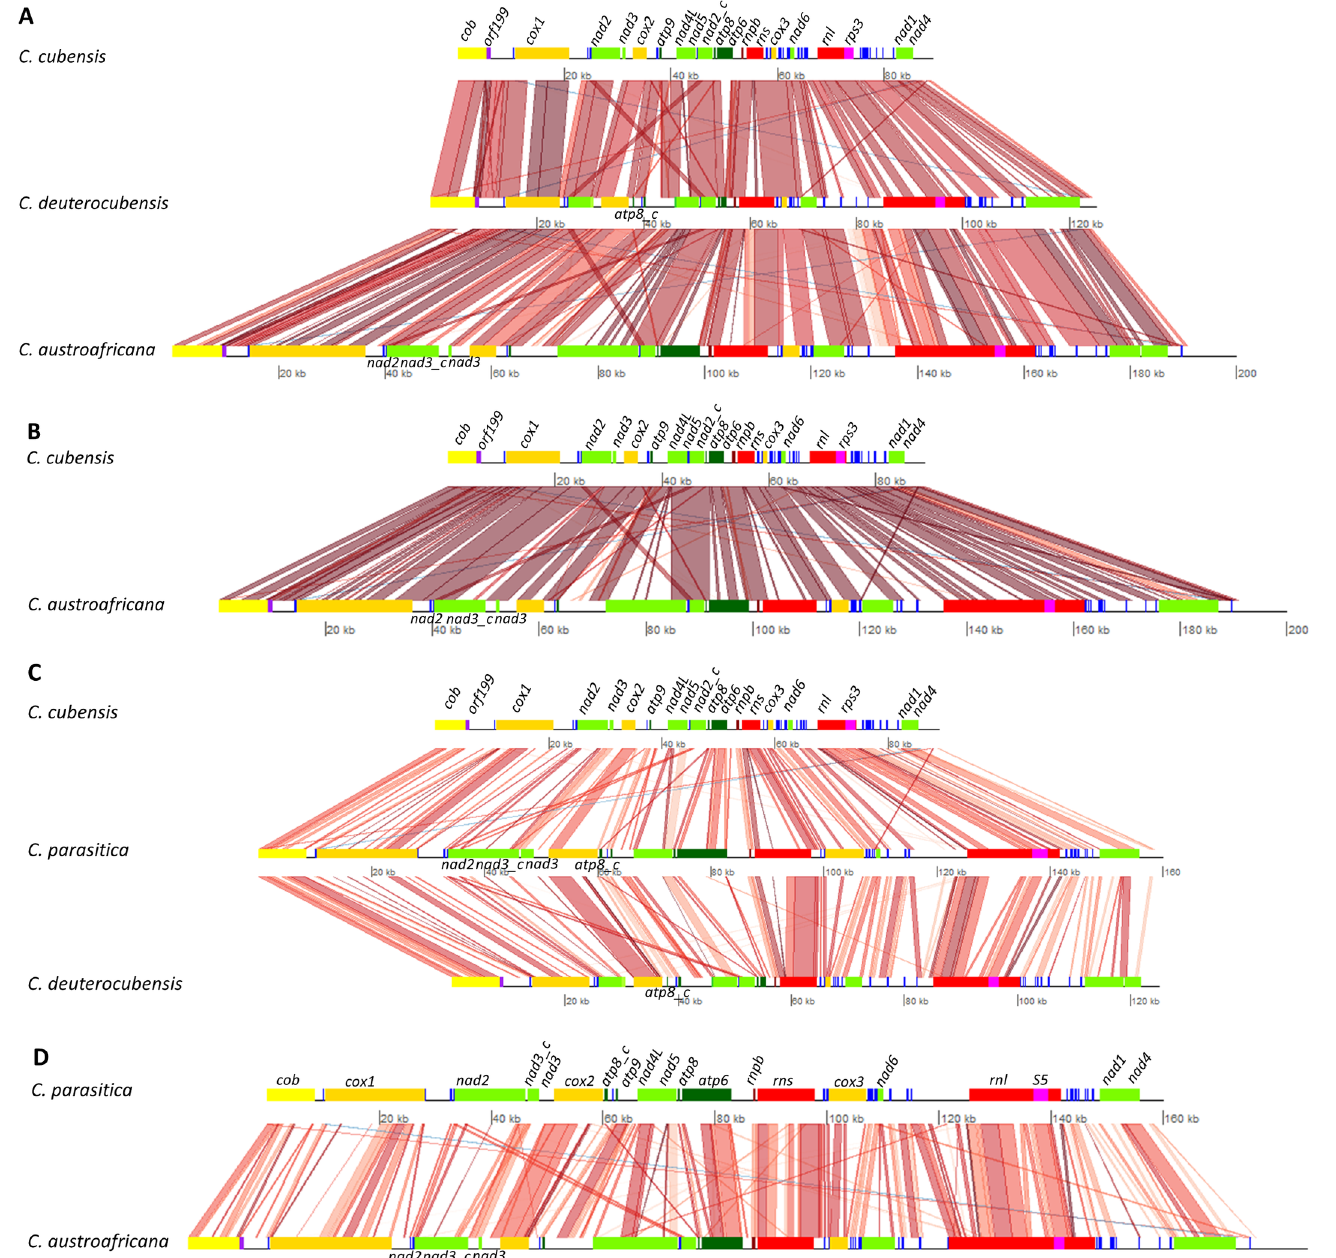
Fig 2. Mitochondrial genome synteny maps. A . Synteny comparisons between C . cubensis , C . deuterocubensis and C . austroafricana . B . Synteny comparison between C . cubensis and C . austroafricana . C . Comparisons between C . cubensis , C . parasitica and C . deuterocubensis . D . Comparison between C . parasitica and C . austroafricana . The Blast2Seq feature in NCBI was used to identify syntenic blocks using BLASTN. Alignments of length of greater than 100 bp and e-value > = 0.00005 are shown. Yellow boxes represent cox genes, gold; cob , lawn green; nad genes, green; atp synthase genes, blue; tRNAs , red; ribosomal RNAs and purple; rps3 . Synteny graphs were generated using GenoPlotR. Two tRNA-Gly genes were predicted in C . austroafricana , while only one was predicted in the other mt genomes. Likewise, two tRNA-Lys genes were predicted in the C . deuterocubensis mt genome, compared to one in the other mt genomes (Fig 1 and S2 Table).